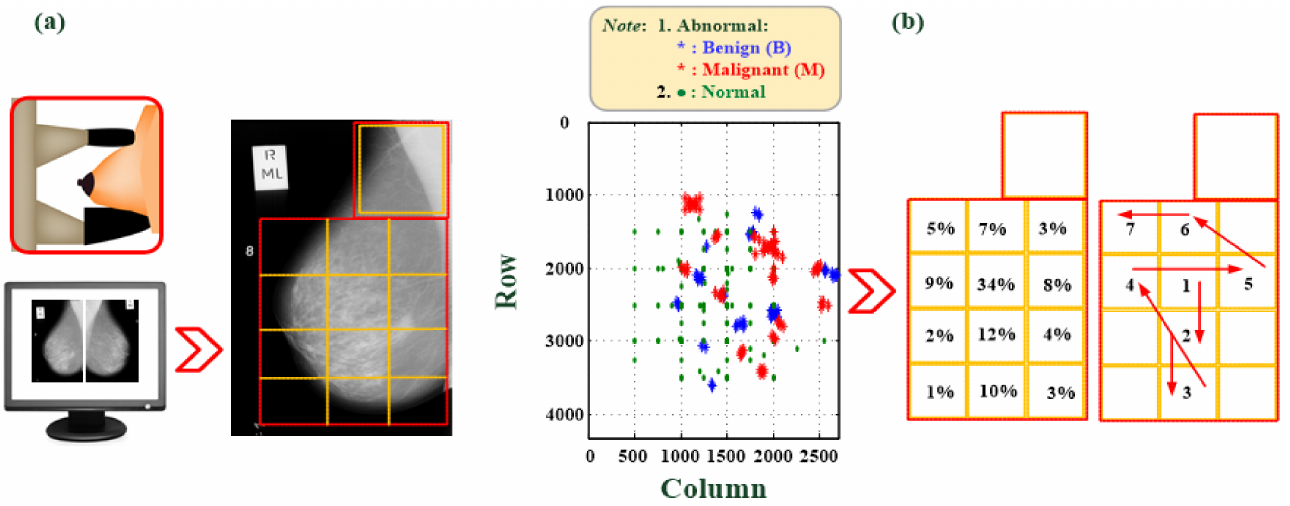
Figure 2. ROI block cutting and priority extraction. ( a ) The statistics of the prevalence of malignant and benign tumors; ( b ) priority of ROI block for automatic ROI